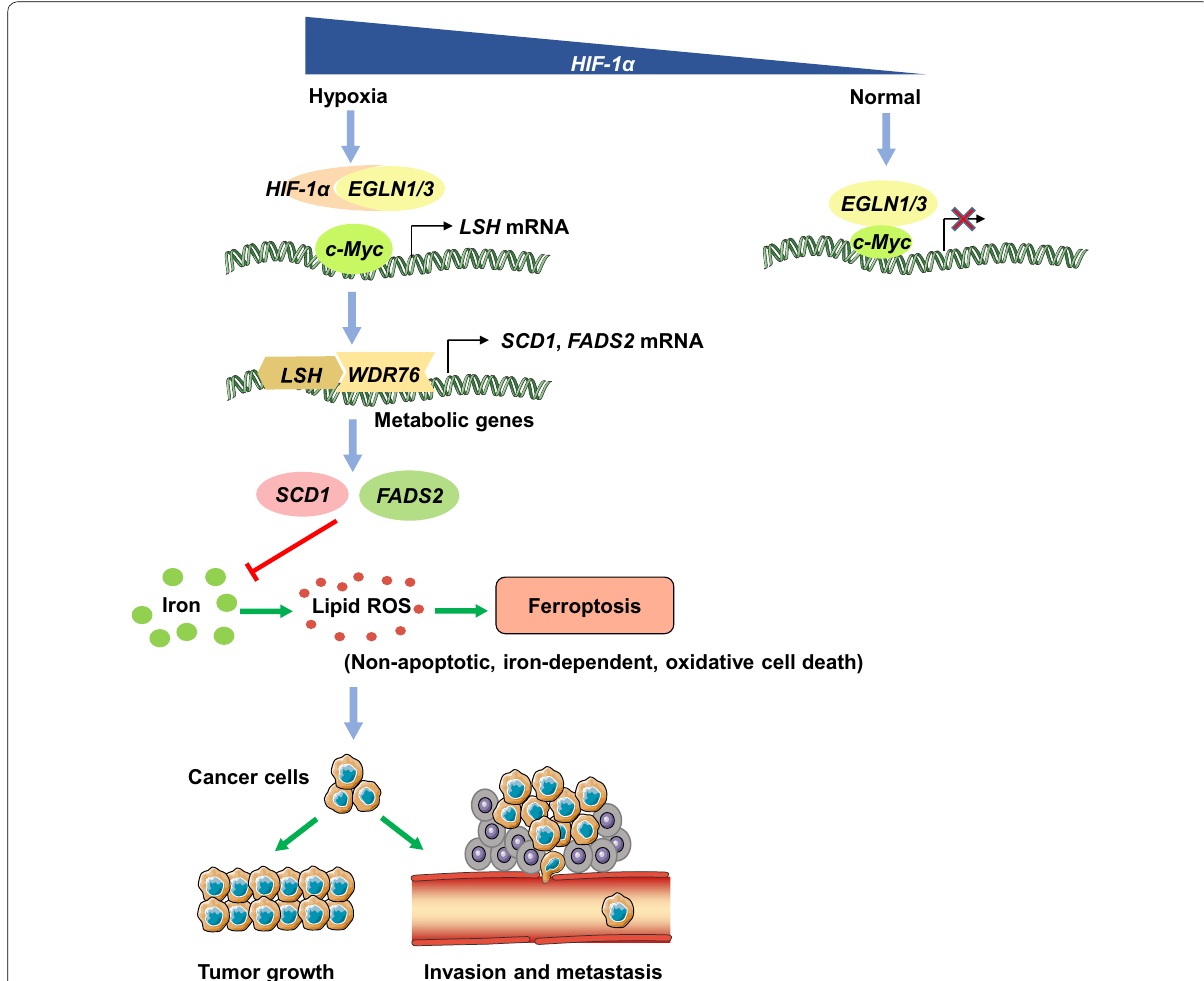
Fig. 1 LSH -mediated inhibition of ferroptosis and enhancement of lung tumorigenesis. In this model, LSH acts as a novel inhibitor of ferroptosis by regulating several metabolism-related genes. LSH expression is up-regulated by c - Myc , which is enriched at the LSH promoter by the EGLN1 -medi- ated repression of HIF - 1α . The induced LSH interacts with WDR76 , which, in turn, up-regulates the lipid metabolic genes including SCD1 and FADS2 . These metabolic genes inhibit the accumulation of lipid ROS and intracellular iron, which are required for ferroptosis, and inhibition of ferroptosis by LSH ultimately promotes cancer progression. HIF-1α hypoxia-inducible factor-1α, EGLN1/3 Egl-9 family hypoxia-inducible factor 1/3, LSH lymphoid- specific helicase, WDR76 WD repeat-containing protein 76, SCD1 stearoyl-CoA desaturase 1, FADS2 fatty acid desaturase 2, ROS reactive oxygen